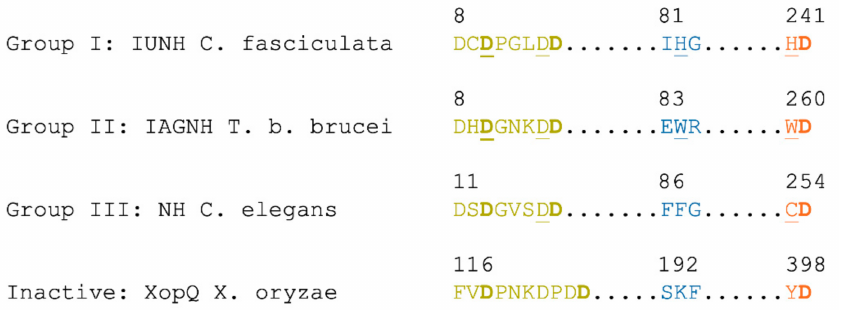
Figure 2. NH fingerprint sequence in NH enzymes and NH-like proteins. In bold are the Asp residues that are involved in the coordination of the Ca 2+ ion. Underlined are the amino acid residues in each group that have been demonstrated through site-directed mutagenesis to be involved in catalysis. The color scheme matches the one used in the active site representations. The sequences are taken from the deposited PDB files (PDB codes 2MAS, 4I71, 5MJ7,